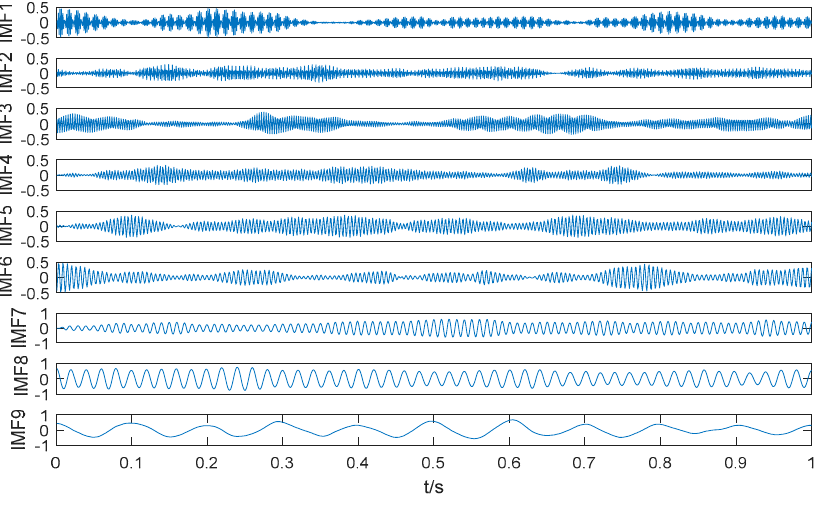
Figure 4. The VMD result for the noisy signal. Table 1. The frequency distribution of IMFs by VMD.